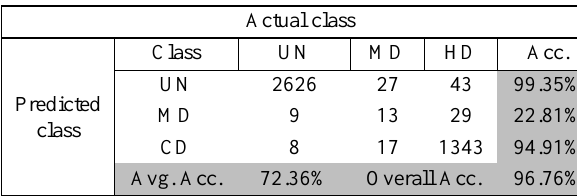
Table 6. Confusion matrix of SVM Classification